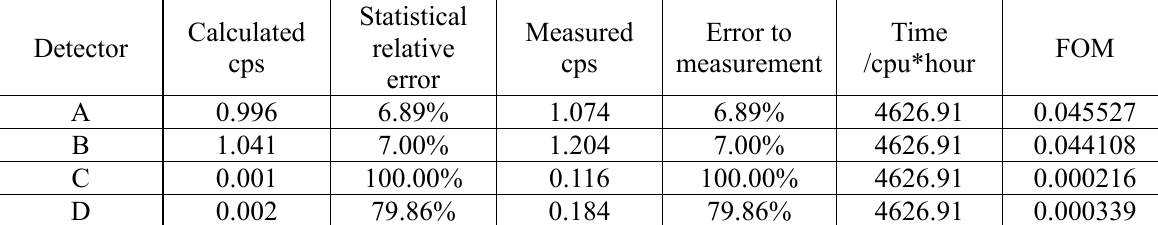
Table II. : Results calculated by MCNP with the optimized imp setting based on experiences